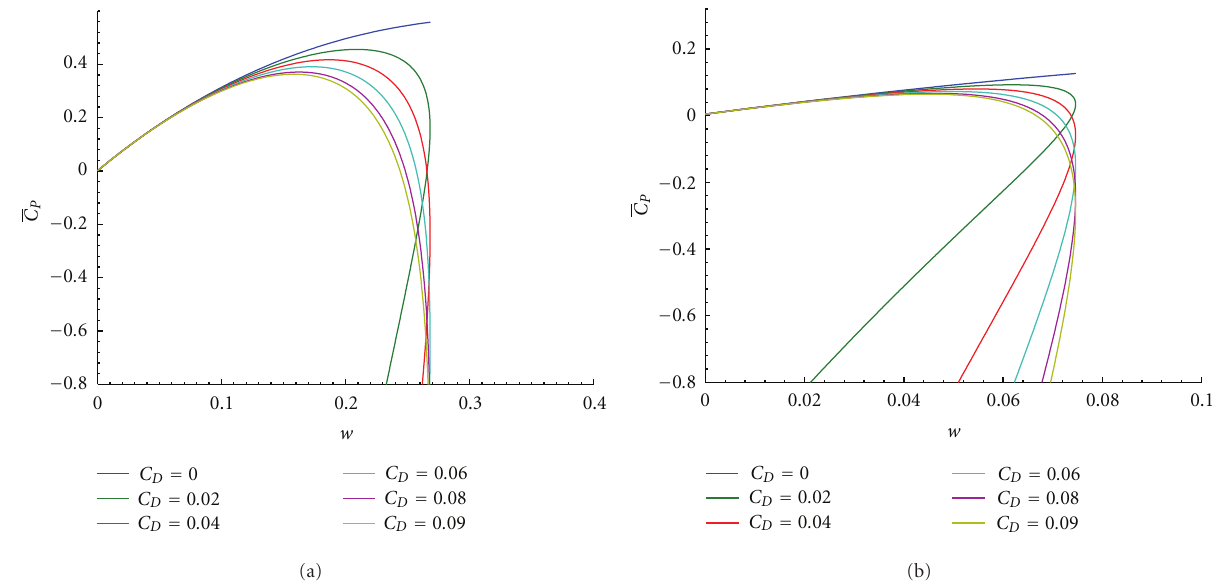
Figure 19: (a) C P versus w for θ = 3 ◦ and γ = 15 ◦ and (b) C P versus w for θ = 3 ◦ and γ = 60 ◦